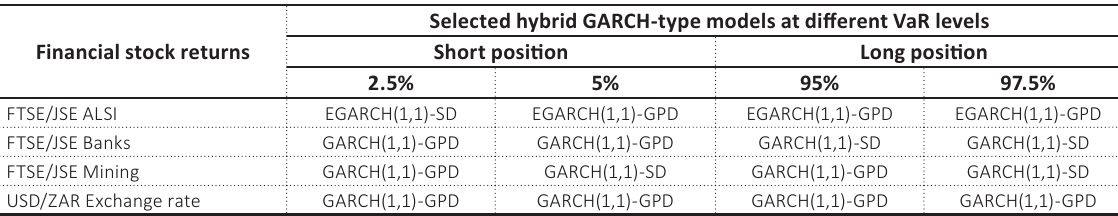
Table 9. Most appropriate hybrid GARCH-type model selected for financial indices and USD/ZAR exchange rate returns at different VaR levels Financial stock